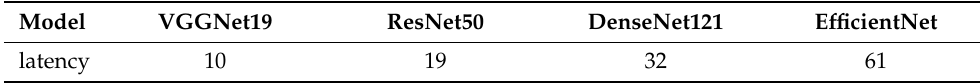
Table 11. The average time taken to classify a pathology